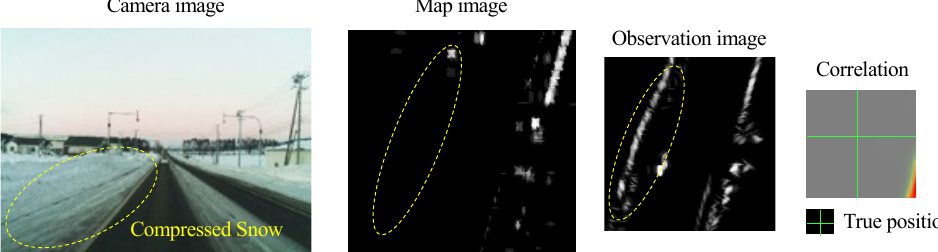
Figure 19. Example of incorrect matching of radar images. The area corresponding to the compressed snow shown in the camera image is circled by a dotted line in the map and observation images. It can be found that objects that do not exist in the map image appear in the observation image. Because the features between the two images are quite different, a peak of correlation appears at a location that deviated from the true position due to the